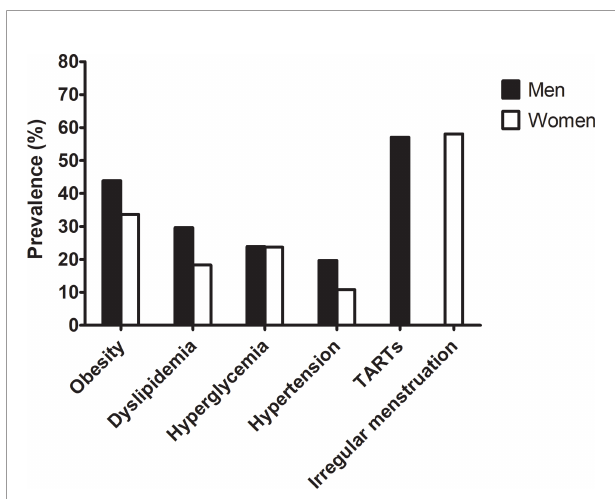
FIGURE 1 | Prevalence of metabolic risk and gonadal dysfunction in the adult CAH patients according to sex.